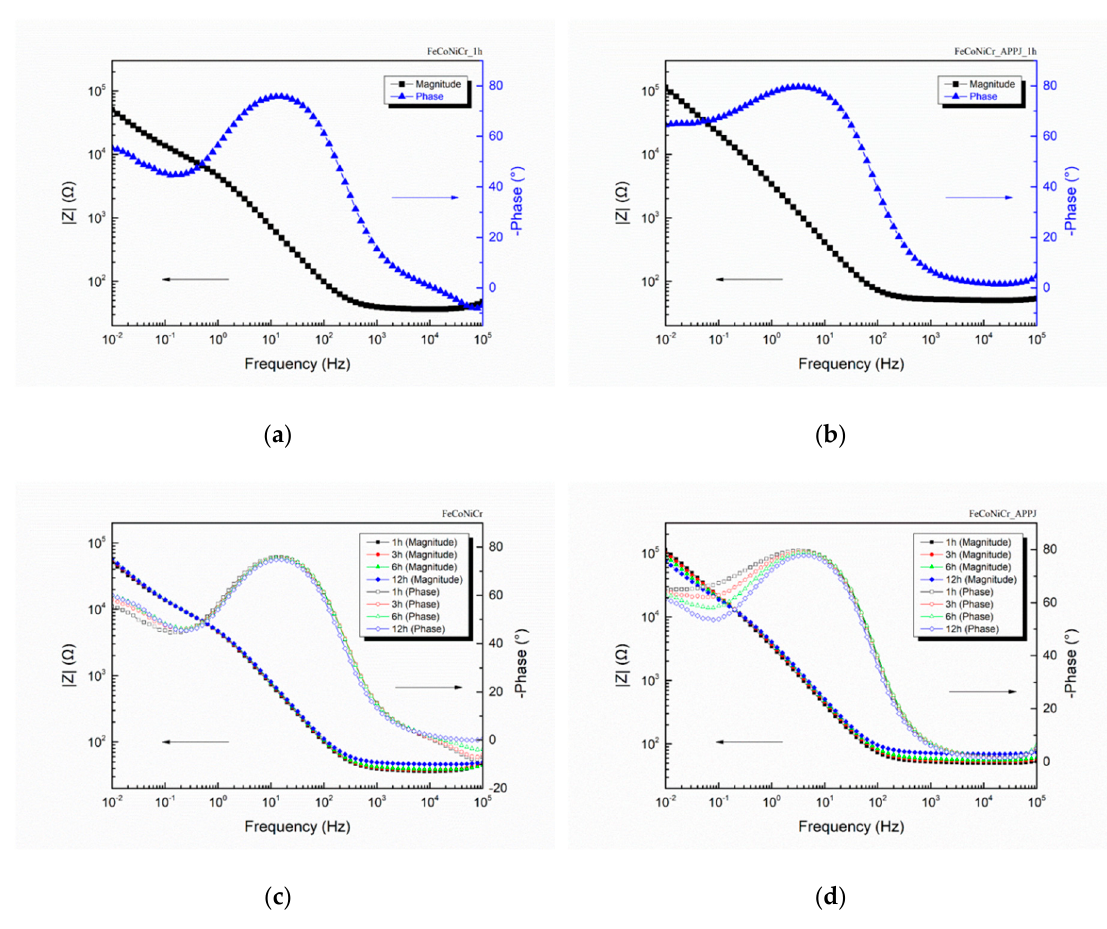
Figure 5. Bode magnitude and Bode phase plots of ( a ) bare MEA after 1 h, ( b ) APPJ-treated MEA after 1h, ( c ) bare MEA for 12 h, and ( d ) APPJ-treated MEA for 12 h.